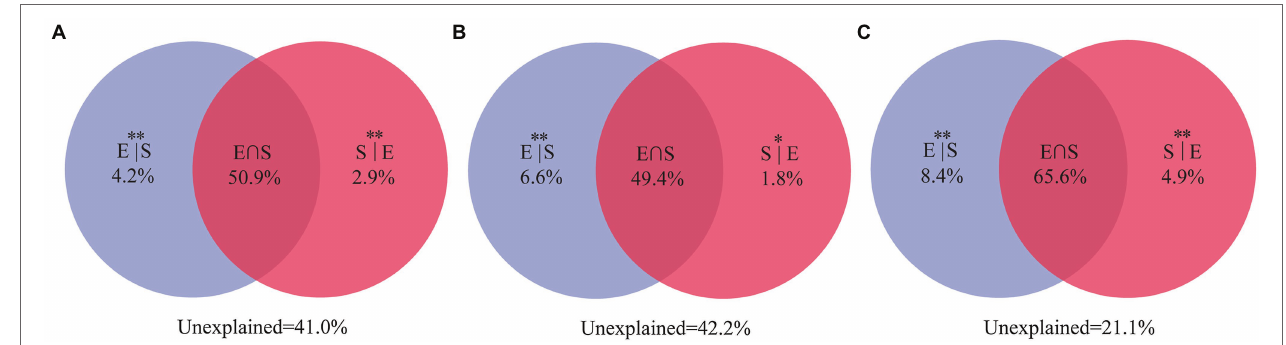
FIGURE 7 | Variation partitioning analyses showing the percentages of variance in water bacterial communities explained by environmental factors and spatial distance. (A) For the entire community, including three environmental factors (TOC, IC, and pH) and spatial distance; (B) for the entire community, including two selected environmental factors (TOC and IC) and spatial distance; and (C) for unique taxa, including two selected environmental factors (TOC and IC) and spatial distance. The variation explained by pure spatial and environmental factors correspond to the bacterial community without the effect of the other by the ANOVA permutation tests. * p < 0.05 and ** p < 0.01. S|E, pure spatial variation; E|S, pure environmental variation; S ∩ E share explained variation; and 1 − S|E − E|S − S ∩ E = unexplained